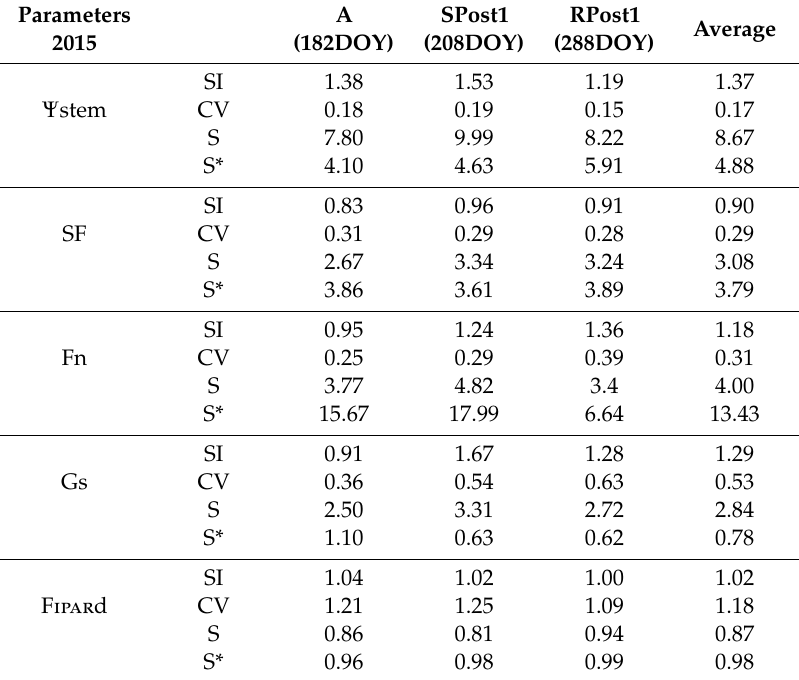
Table 3. Mean values of each parameter in the CON and D treatments, signal intensity, coe ffi cient of variation and sensitivity determined according to the traditional (S) and corrected (S*) methods in 2015.